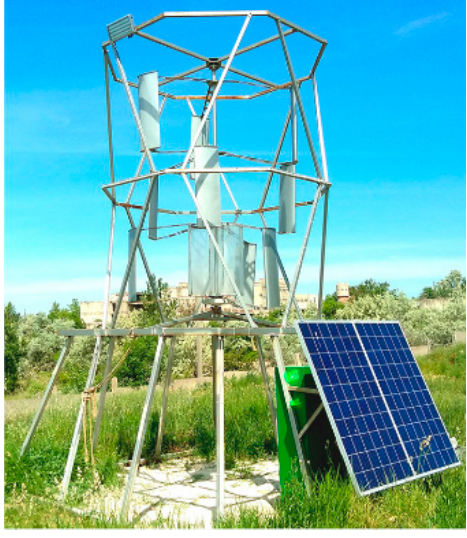
Figure 11. Combined wind-solar power plant with a three-section Darier rotor and two photoelectric modules (Sevastopol, SRC «Horizont»).